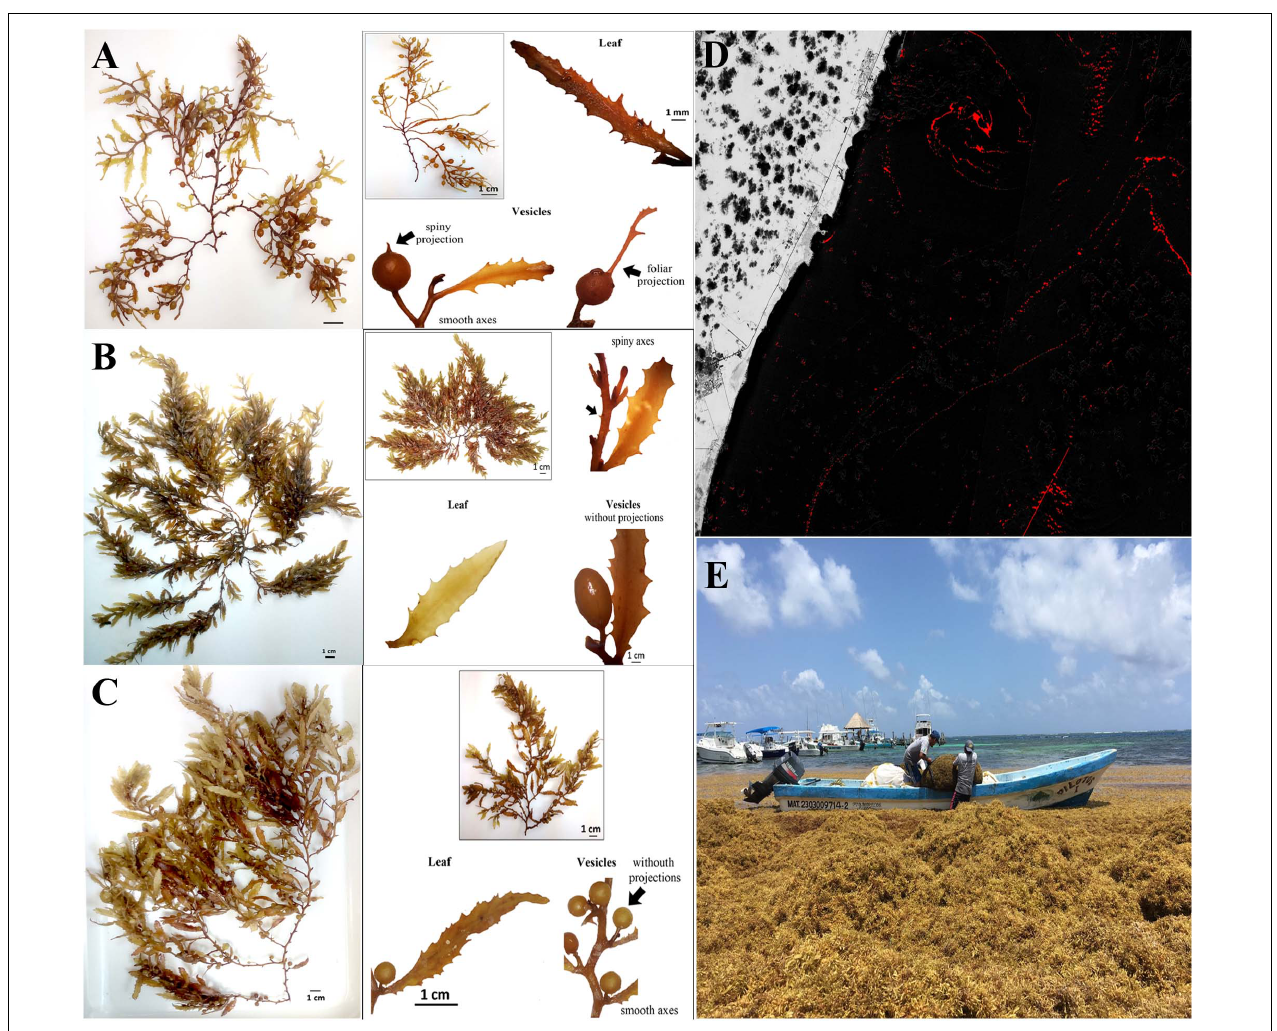
FIGURE 1 | Pelagic taxa involved in the Sargassum events at the Caribbean. (A) : Sargassum natans I; (B) : S. fluitans III; (C) : S. natans VIII (Parr, 1939). Scale: 1 cm. Leaf shape, axes and shape of vesicles are shown. For detailed morphological descriptions see Vázquez-Delfín et al., 2020. (D) : Sentinel-2 satellite image for the north coast of the Mexican Caribbean coast showing Sargassum floating biomass (red); (E) : Management of Sargassum stranded biomass in the Mexican Caribbean